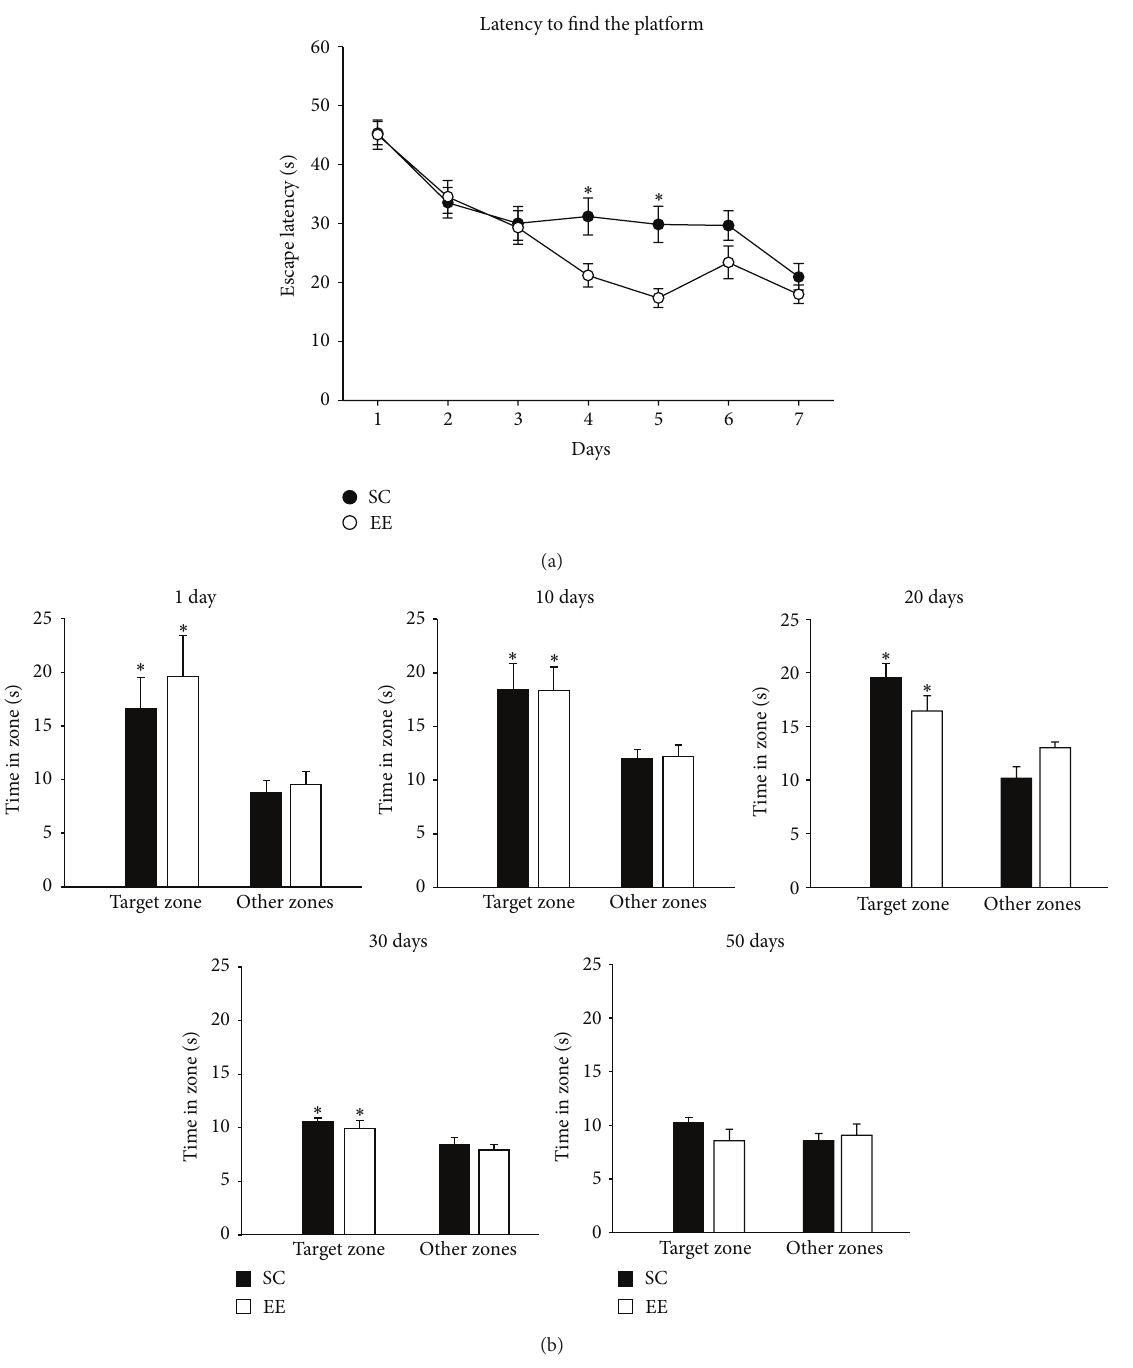
Figure 1: (a) Performances of SC ( 𝑛 = 24 ) and EE ( 𝑛 = 24 ) mice in the MWM. There is a significant learning effect (two-way RM ANOVA, 𝑃 = 0.016 ), and a housing condition × day interaction (two-way RM ANOVA post hoc analysis Holm-Sidak method, for day 4, 𝑃 = 0.005 ; for day 5, 𝑃 = 0.001 ). ∗ = statistical significance; error bars = s.e.m. (b) Evaluation of spatial memory for SC (1 day 𝑛 = 5 ; 10 days 𝑛 = 5 ; 20 days 𝑛 = 5 ; 30 𝑛 = 5 , 50 𝑛 = 4 ) and EE (1 day 𝑛 = 5 ; 10 days 𝑛 = 5 ; 20 days 𝑛 = 5 ; 30 𝑛 = 5 ; 50 𝑛 = 4 ) mice. Time spent in the target zone ( 𝑇 ), where the platform was placed, versus other equivalent zones ( 𝑂 ), for recall probe tests. One-way ANOVA, post hoc analysis Holm-Sidak method, 1 day probe test : in SC group, 𝑇 versus 𝑂 , 𝑃 = 0.044 ; in EE group, 𝑇 versus 𝑂 , 𝑃 = 0.036 ; 10 days probe test : in SC group, 𝑇 versus 𝑂 , 𝑃 = 0.037 ; in EE group, 𝑇 versus 𝑂 , 𝑃 = 0.043 ; 20 days probe test : in SC group, 𝑇 versus 𝑂 , 𝑃 < 0.01 ; in EE group, 𝑇 versus 𝑂 , 𝑃 = 0.048 ; 30 days probe test : in SC group, 𝑇 versus 𝑂 , 𝑃 = 0.025 ; in EE group, 𝑇 versus 𝑂 , 𝑃 = 0.048 ; 50 days probe test : in SC group, 𝑇 versus 𝑂 , 𝑃 = 0.070 ; in EE group, 𝑇 versus 𝑂 , 𝑃 = 0.226 . ∗ = statistical significance; error bars =